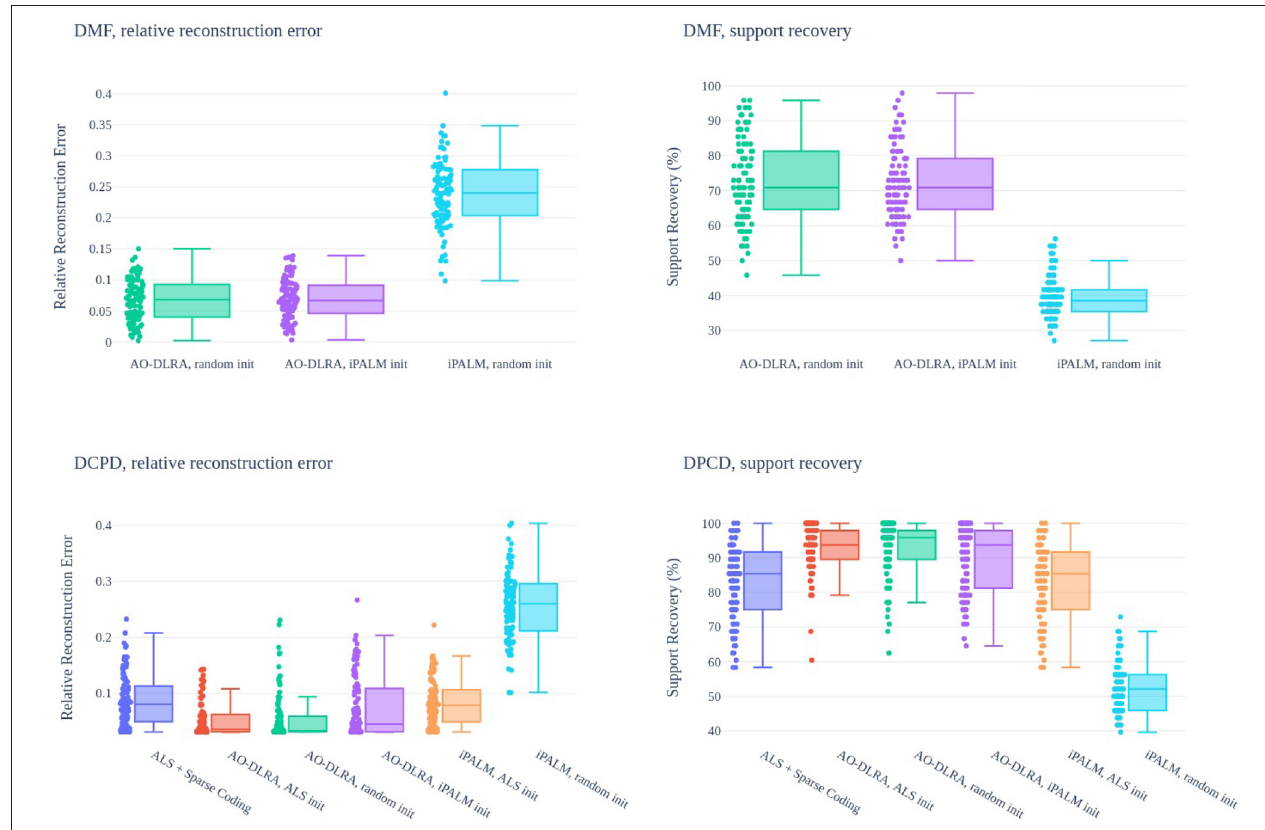
FIGURE 6 | Relative reconstruction error (left) and support recovery ( right , in % ) for DMF algorithms (top) and DCPD algorithms (bottom) . One shared initialization is used for the randomly initialized methods, and 100 instances of each problem are tested. AO-DLRA, iPALM init is when the result of iPALM, random init is used as an initialization for